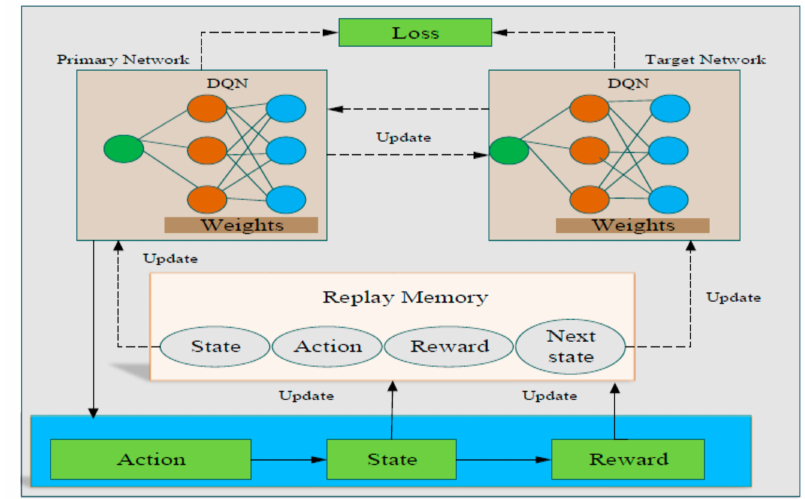
Figure 1. Overall architecture of deep reinforcement